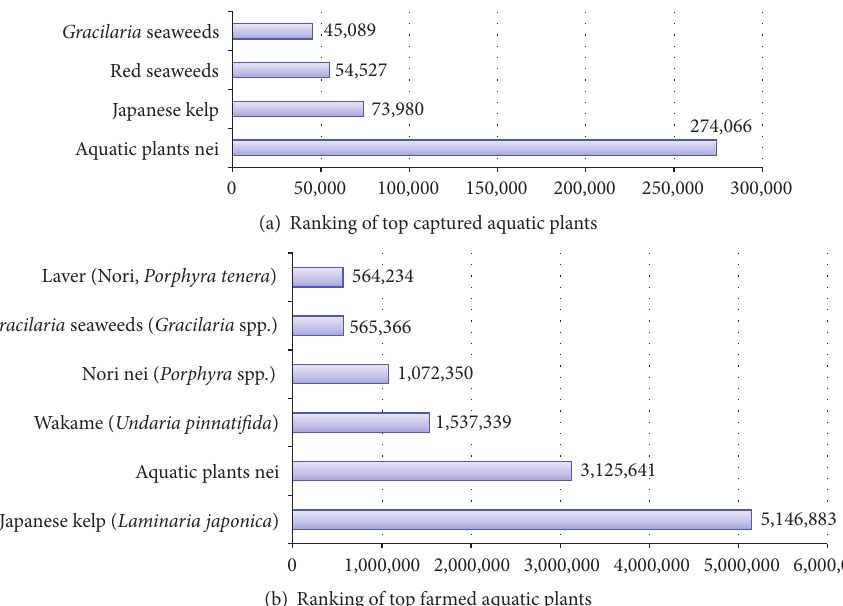
Figure 6: Captured and farmed aquatic plant food species in 2010 (data in tonnes) [118,